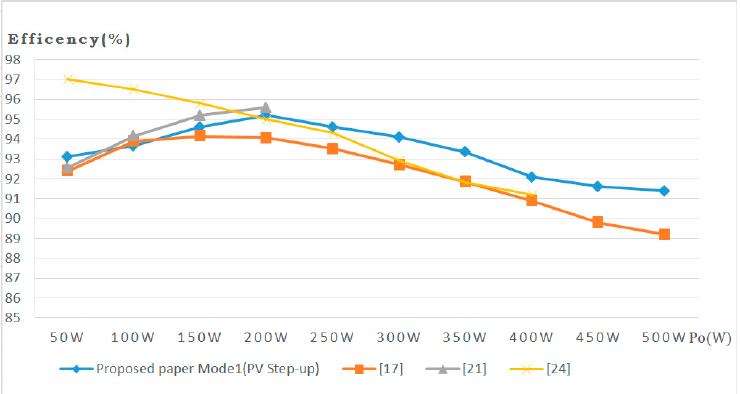
Figure 15. Efficiency curve of proposed three-port bidirectional converter. Figure 15. E ffi ciency curve of proposed three-port bidirectional converter.